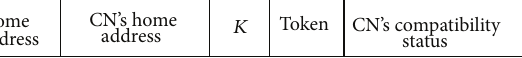
Figure 3: CN compatibility list